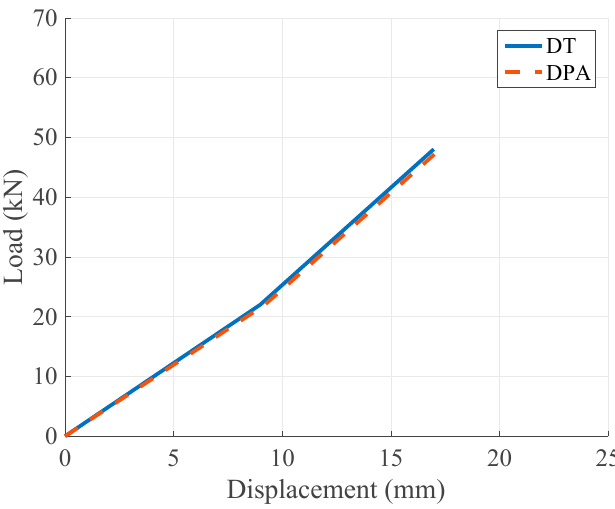
Figure 9. Displacements comparison for beam#1 LC1.